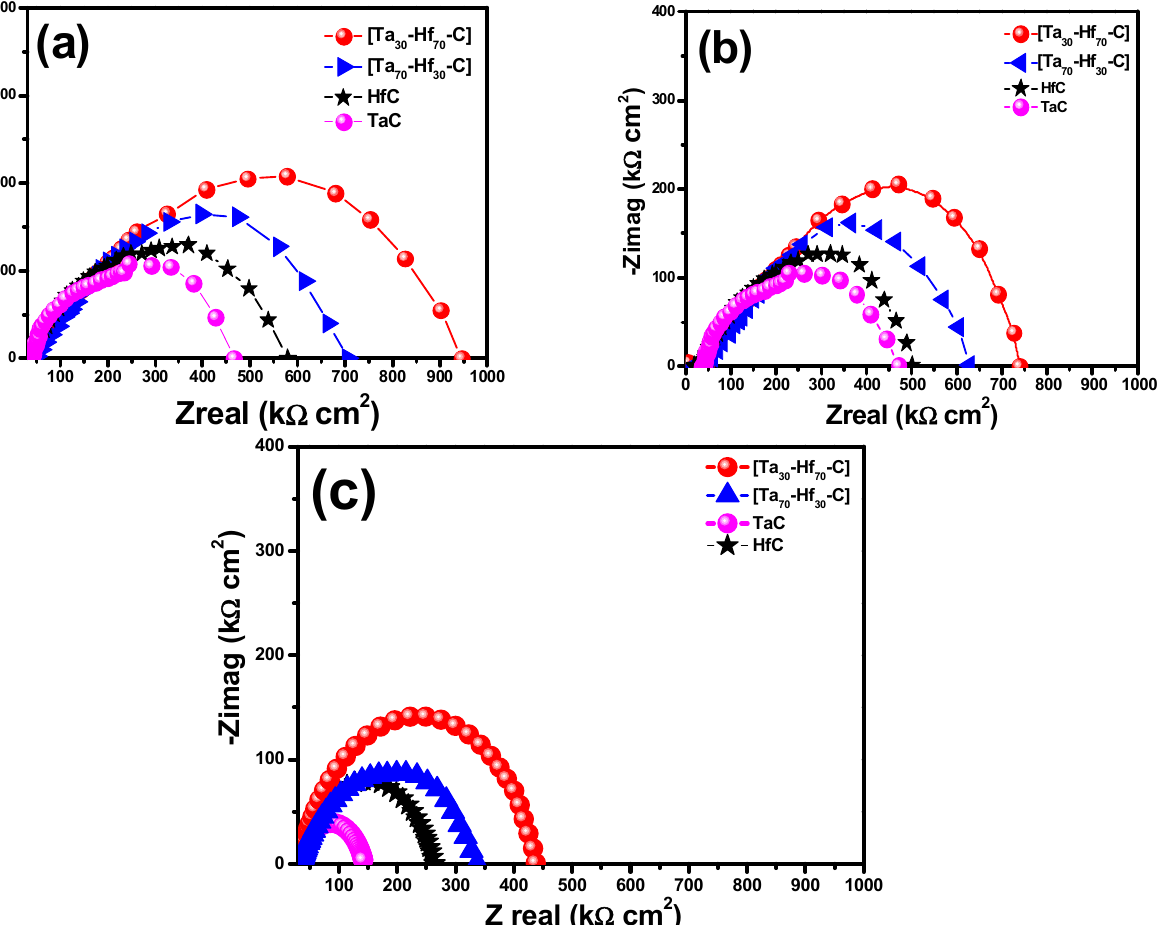
Figure 11. Nyquist diagram corresponding with individual coatings and composites as a function of the incidence angles ( a ) 30°, ( b ) 60° and ( c ) 90°.